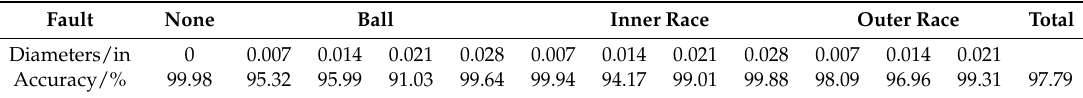
Table 6. Accuracy of test samples in 12 conditions using Pythagorean Spatial Pyramid Pooling Convolutional Neural Network